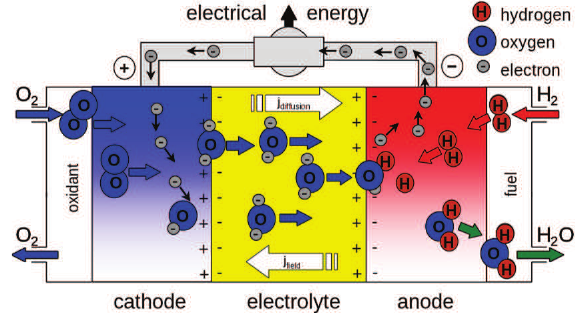
Figure 1. The general structure of the solid oxide fuel cell